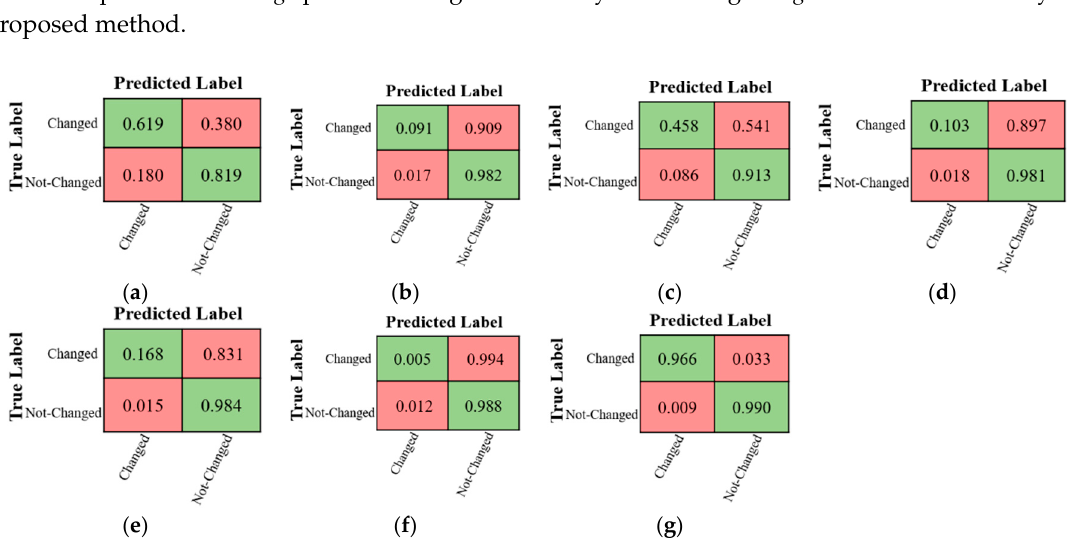
Figure 11. The confusion matrices of different CD methods for the Multispectral-Abudhabi dataset. ( a ) CVA-SVM, ( b ) MAD-SVM, ( c ) PCA-SVM, ( d ) IR-MAD -SVM, ( e ) SFA-SVM, ( f ) 3D-CNN, and ( g ) Proposed Method.